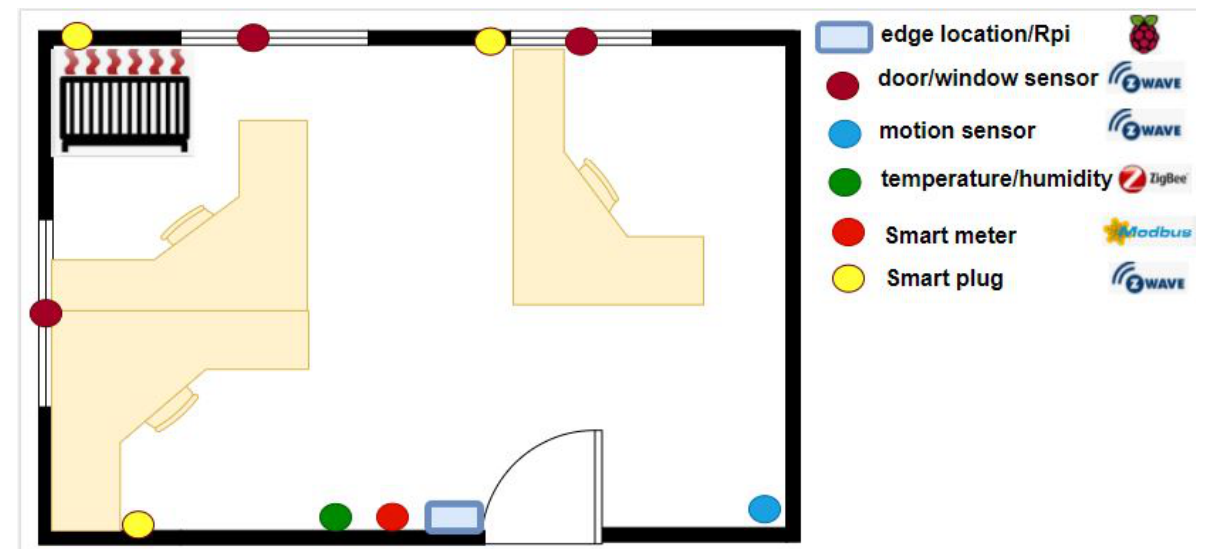
Figure 12. Sensors and devices installation